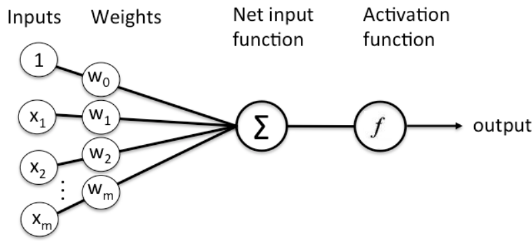
Figure 5. Neural Network